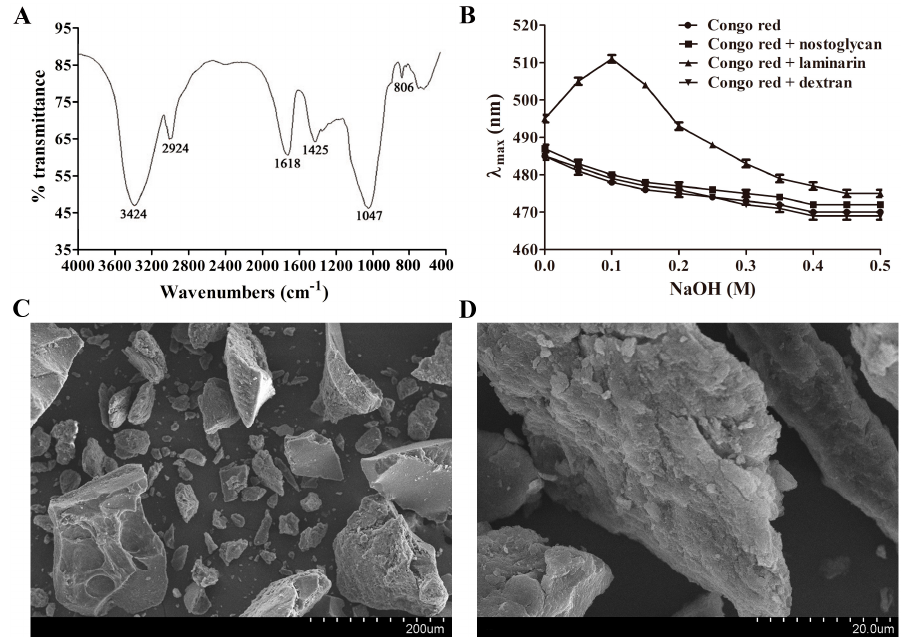
Figure 1. Spectroscopic and physicochemical characterization of nostoglycan. ( A ) FTIR spectrum of nostoglycan in the frequency range of 4000–400 cm − 1 ; ( B ) Triple helical conformation analysis of polysaccharides in aqueous solution. The maximum absorption wavelength of Congo red in the absence or presence of an indicated polysaccharide was recorded by a spectrophotometer under increasing alkaline conditions (0–0.5 M NaOH); ( C , D ) Surface morphology of nostoglycan by scanning electron microscopy at 200× and 2000× magnification, respectively.